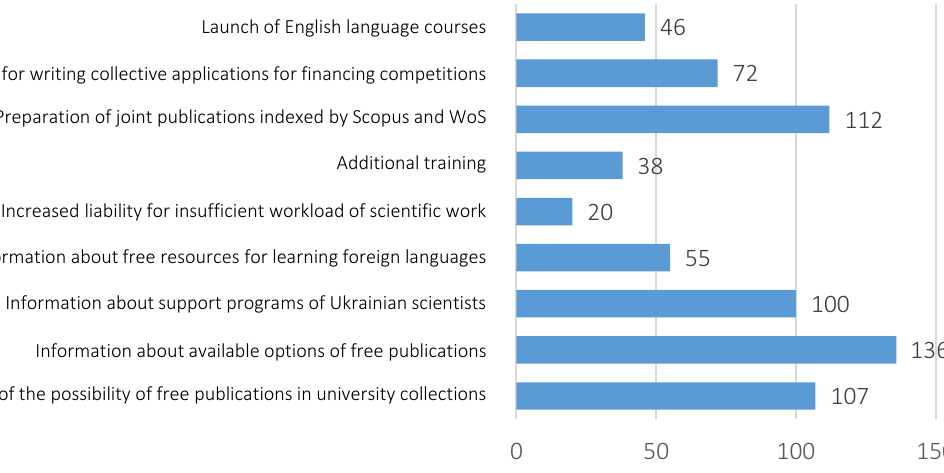
Figure 4. Respondents’ answers to the question “What steps of the scientific department do you consider appropriate for further “reboot” of research